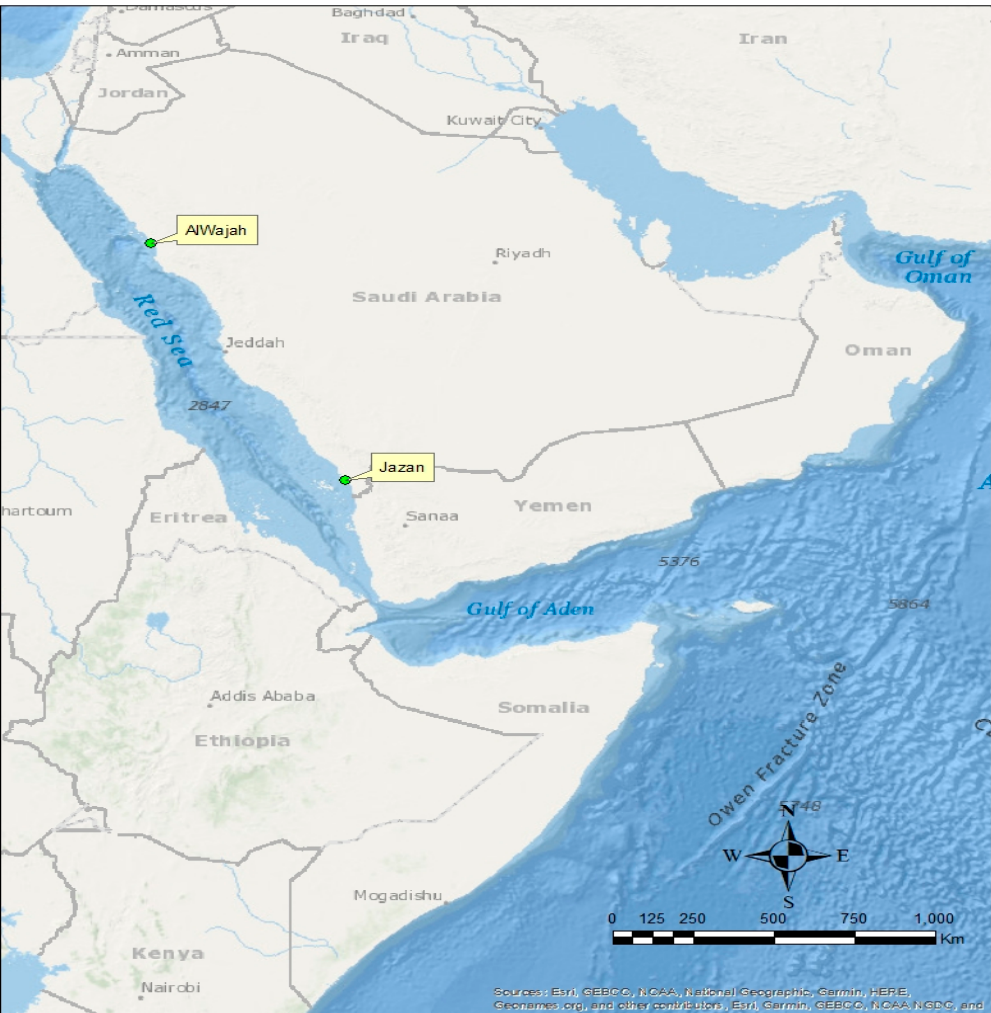
Figure 7. Map showing Al Wajah and Jazan mangrove ecosystems in northern and southern Central Red Sea.